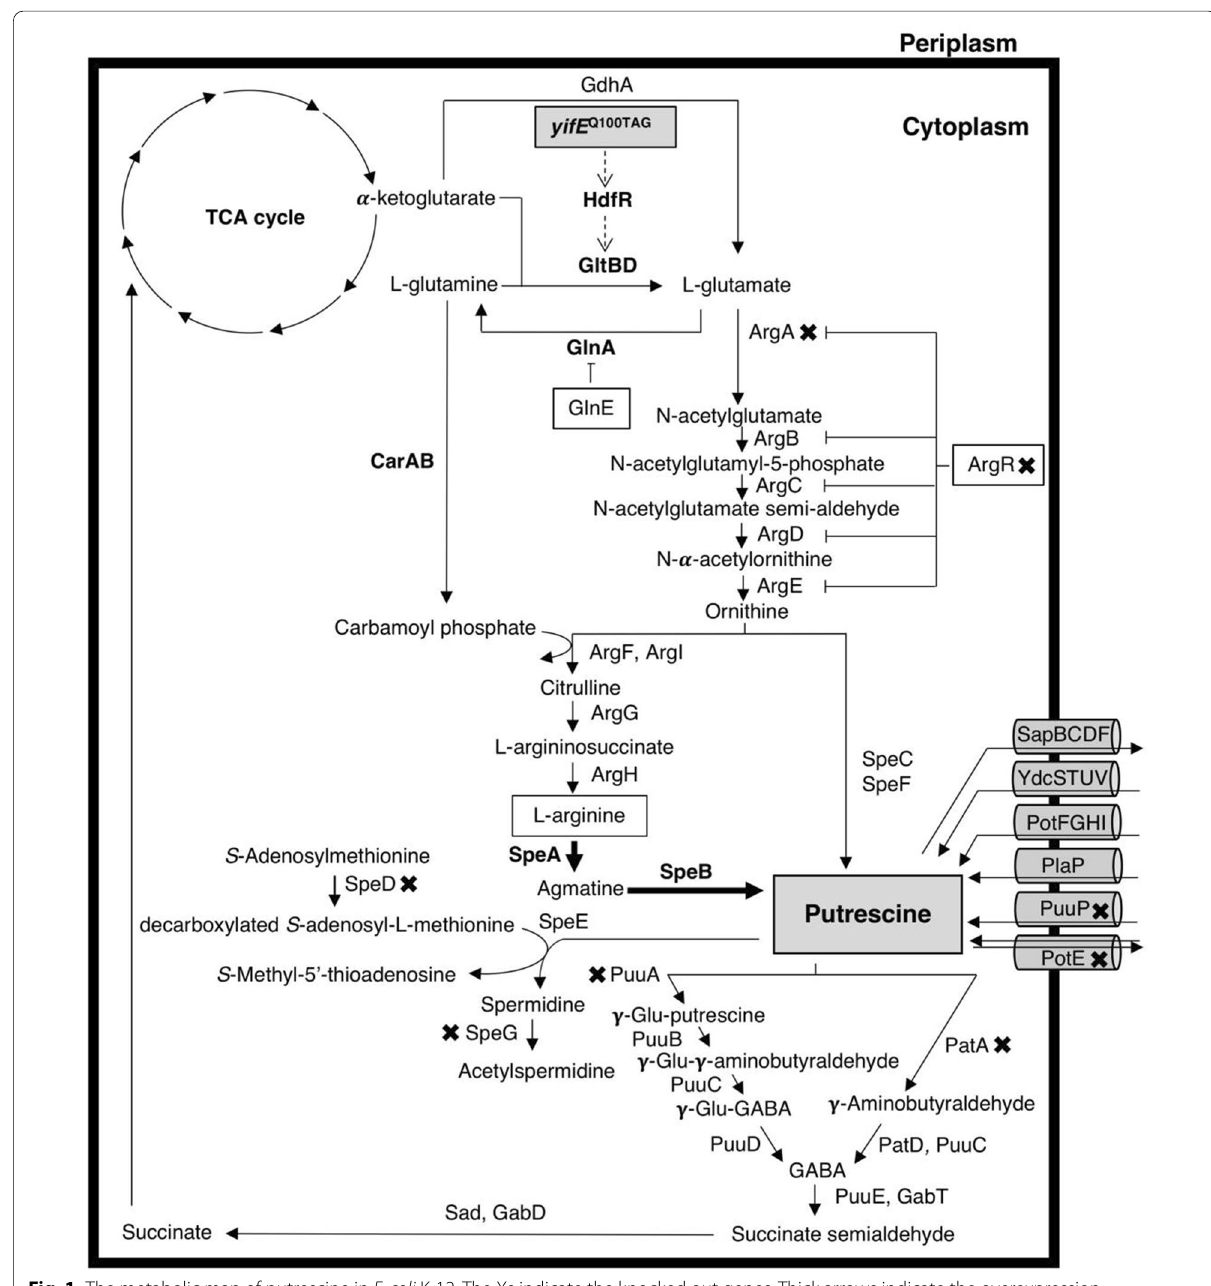
Fig. 1 The metabolic map of putrescine in E. coli K-12. The Xs indicate the knocked out genes. Thick arrows indicate the overexpression of genes. Dash arrows indicate the increased expression of genes. Blunt end arrows indicate inhibition of the expression of genes. GdhA glutamate dehydrogenase, HdfR DNA-binding transcriptional dual regulator HdfR, GltBD glutamate synthase, GlnA glutamine synthetase, GlnE glutamine synthetase adenylyltransferase, CarAB carbamoyl phosphate synthetase, ArgA N -acetylglutamate synthase, ArgB acetylglutamate kinase, ArgC N -acetylglutamylphosphate reductase, ArgD N -acetylornithine aminotransferase, ArgE acetylornithine deacetylase, ArgF ornithine carbamoyltransferase, ArgI ornithine carbamoyltransferase, ArgG argininosuccinate synthetase, ArgH argininosuccinate lyase, ArgR DNA-binding transcriptional dual regulator ArgR, SpeA biosynthetic arginine decarboxylase, SpeB agmatinase, SpeC constitutive ornithine decarboxylase, SpeD S -adenosylmethionine decarboxylase, SpeE spermidine synthase, SpeF inducible ornithine decarboxylase, SpeG spermidine N -acetyltransferase, PatA putrescine aminotransferase, PatD γ-aminobutyraldehyde dehydrogenase, GabT 4-aminobutyrate aminotransferase, GabD succinate-semialdehyde dehydrogenase GabD, Sad succinate-semialdehyde dehydrogenase Sad, PuuA glutamate-putrescine ligase, PuuB γ-glutamylputrescine oxidase, PuuC γ-glutamyl-γ-aminobutyraldehyde dehydrogenase, PuuD γ-glutamyl-γ-aminobutyrate hydrolase, PuuP putrescine importer, YdcSTUV putrescine importer, PotFGHI putrescine importer, PlaP putrescine importer, PotE putrescine-ornithine antiporter/putrescine importer, SapBCDF putrescine exporter, TCA cycle tricarboxylic acid